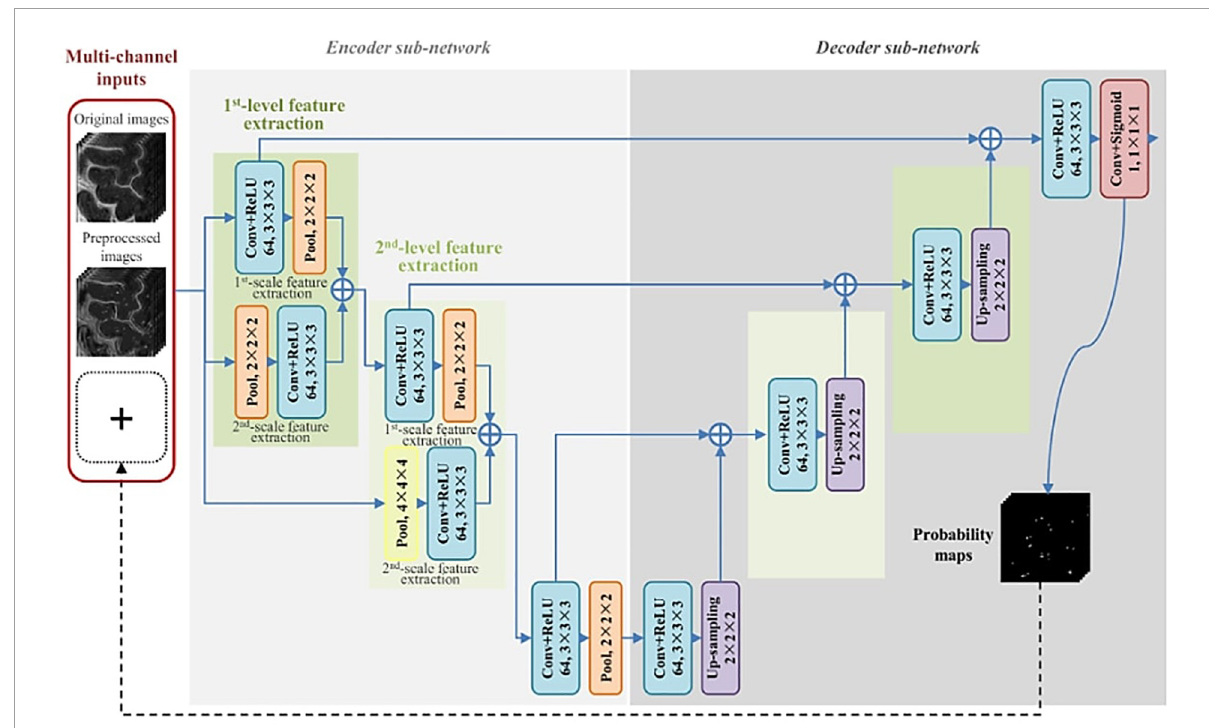
FIGURE9 The M 2 EDN neural network architecture proposed by Lian et al. (2018). M 2 EDN stands for multi-scale, multi-dimensional encoder-decoder network. The model features a Frangi filter segmentation as a second input channel. Conv, convolution; ReLU, rectified linear unit; Pool, max pooling. Reprinted from Lian et al. (2018), with permission from Elsevier, conveyed through the Copyright Clearance Center, Inc.